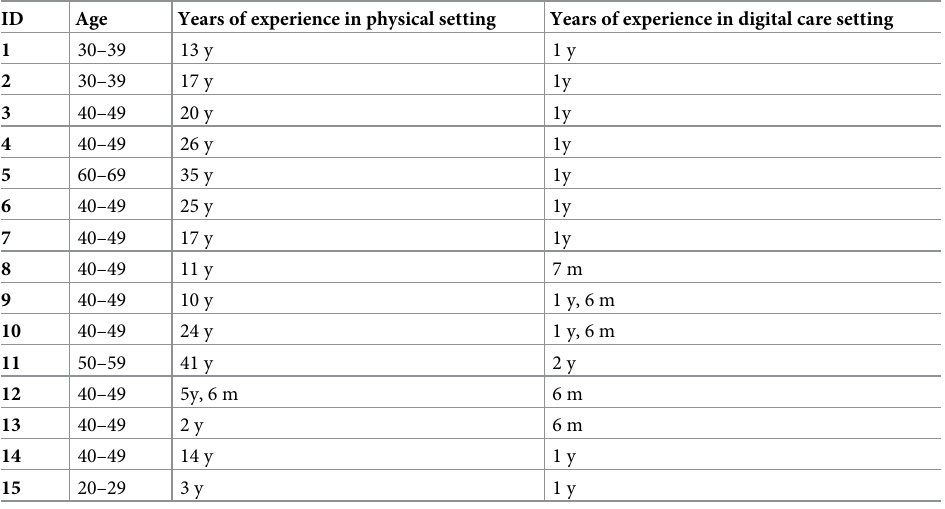
Table 1. Participant